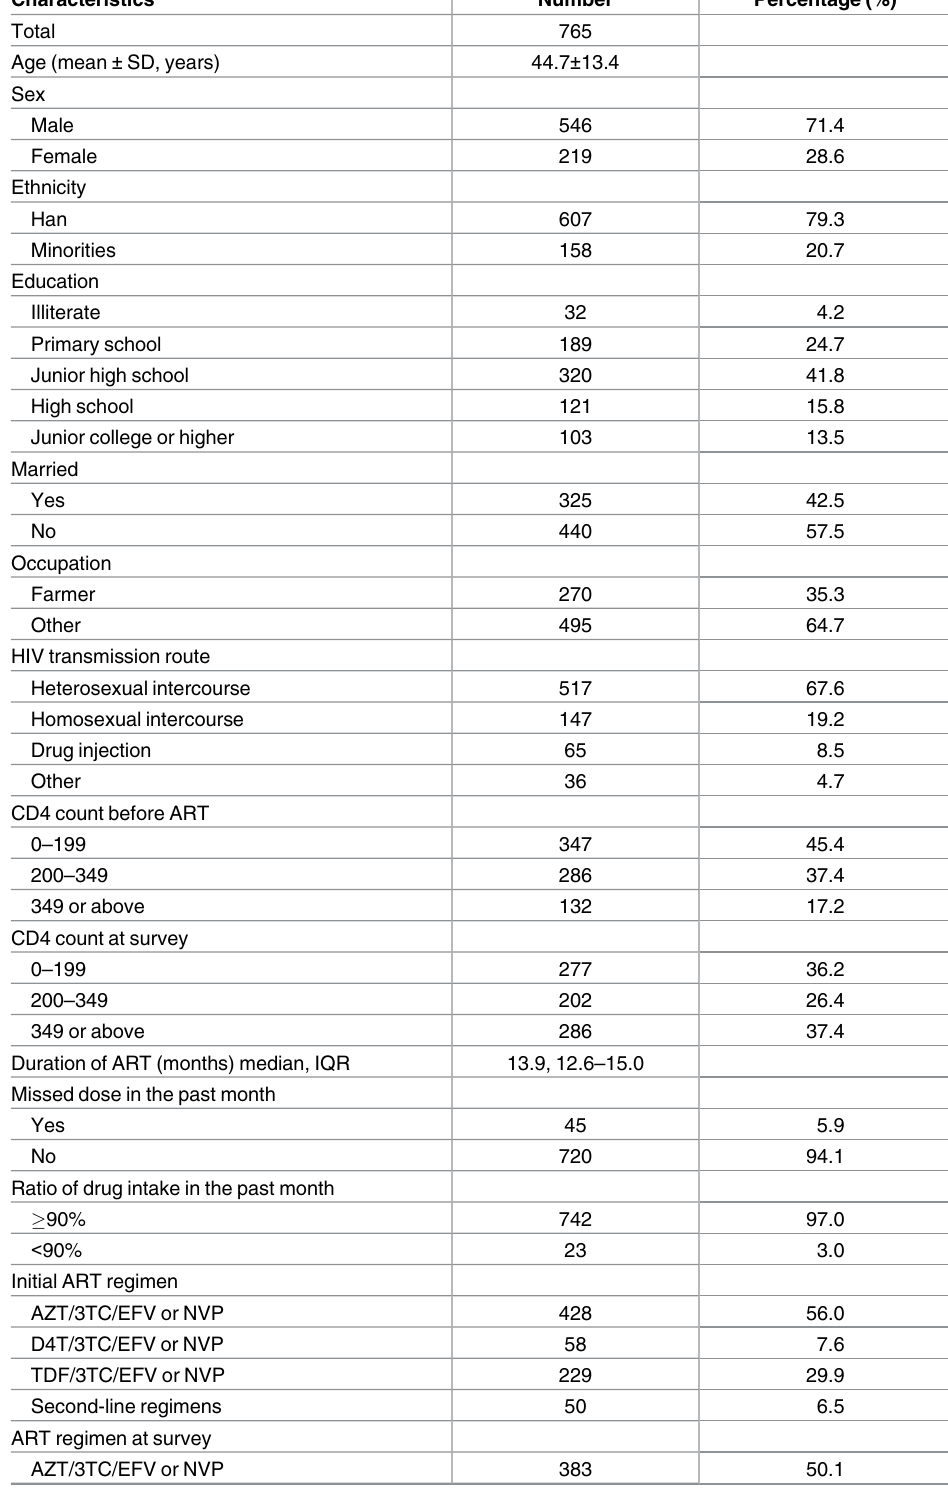
Table 1. Characteristics of HIV patients receiving ART in